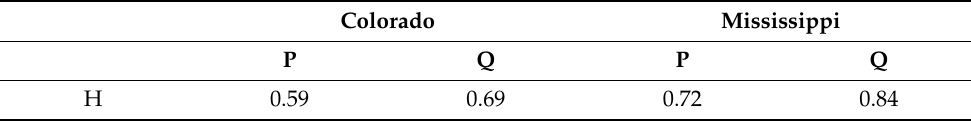
Table 2. H estimates for catchment boundary box average annual precipitation (P) and annual flows (Q) for the Colorado river at Lees Ferry (1906–2013) and the Mississippi at Keokuk (1901–2013). Colorado